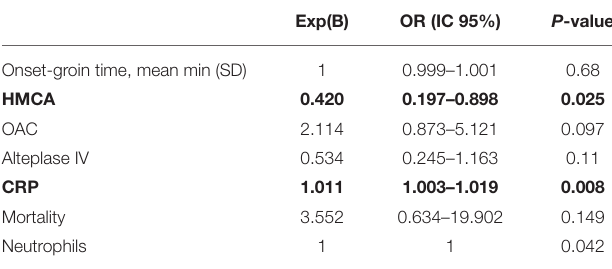
TABLE 2 | Bivariate analysis: patients treated with intravenous (IV) alteplase previous endovascular treatment (EVT).